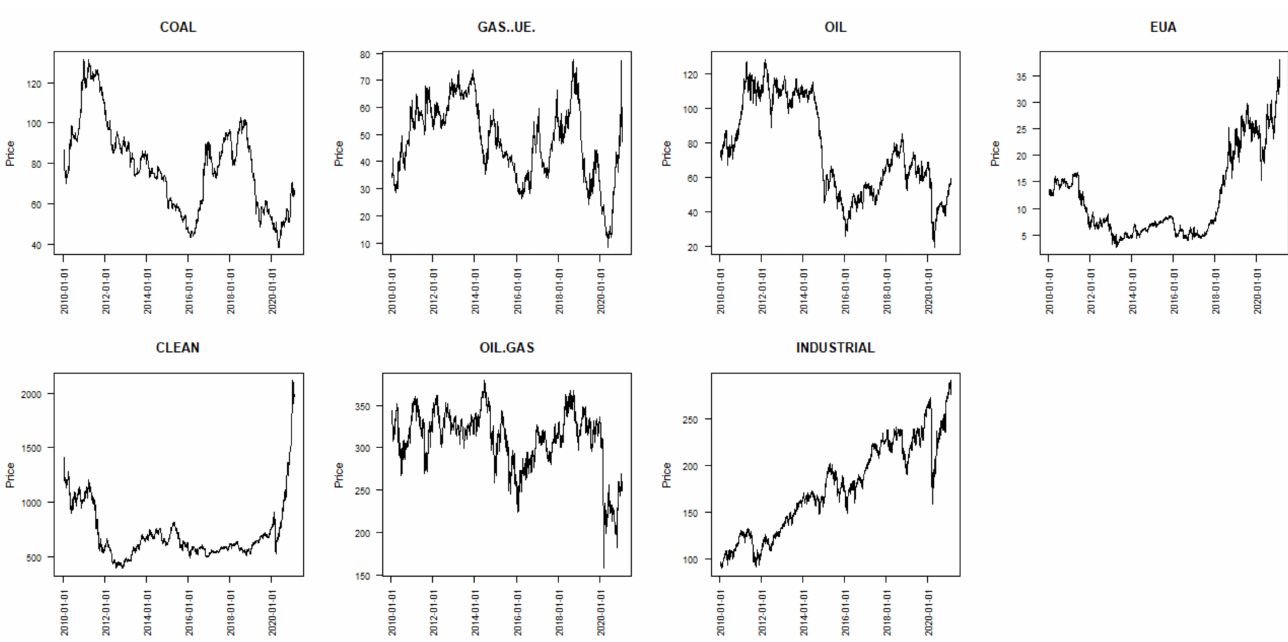
Figure 1. Matrix graph with the evolution of the daily prices of the seven